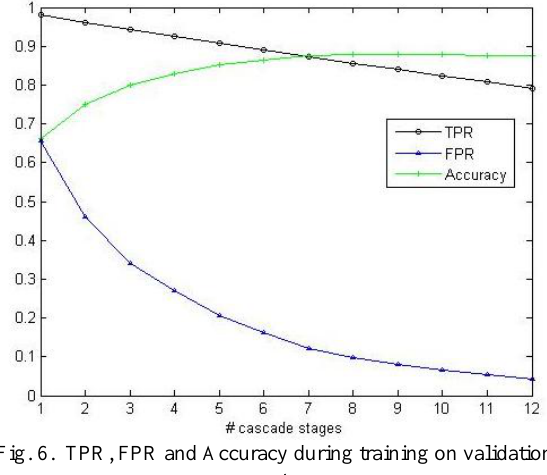
Fig. 6. TPR, FPR and Accuracy during training on validation